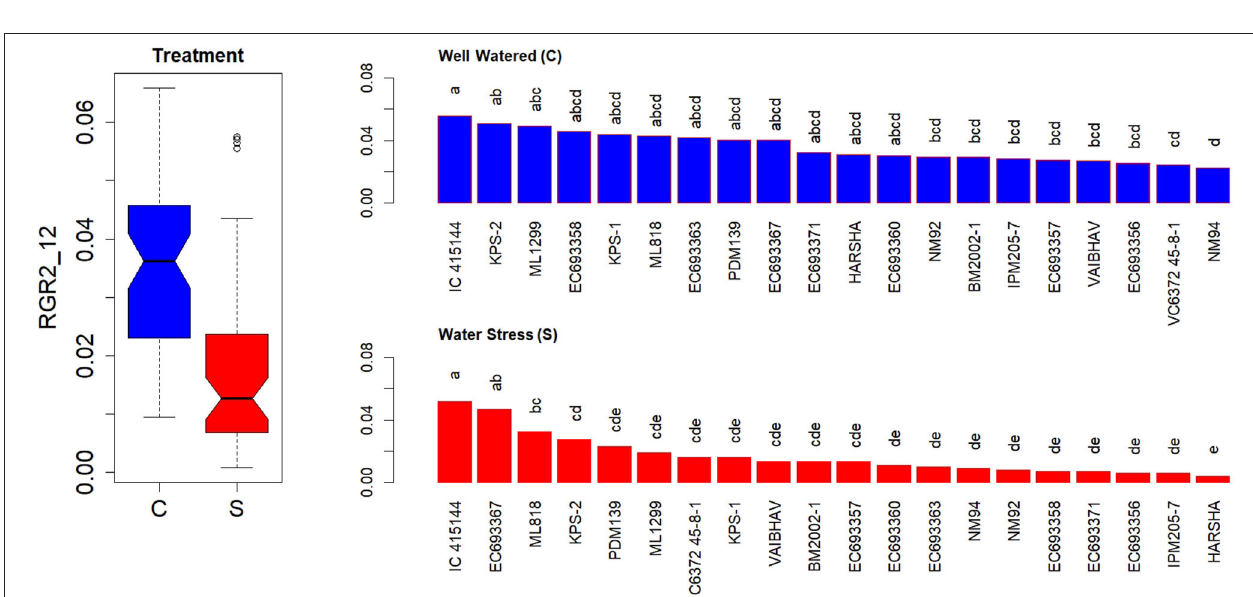
FIGURE 6 | Genetic variation in RGRs during the initial phase in response to two levels in well-watered (C) and water-stressed (S) plants; RGRs were computed for 2–12 days. Each box in the treatment effect represents 60 observations (3 replications and 20 genotypes). Each bar in the genotype effect for each treatment represents mean values of three replications. Letters represent the significance of differences among mean values as computed by the Duncan multiple range test at 0.95 CI. Genotypes with common letters are not significantly different.